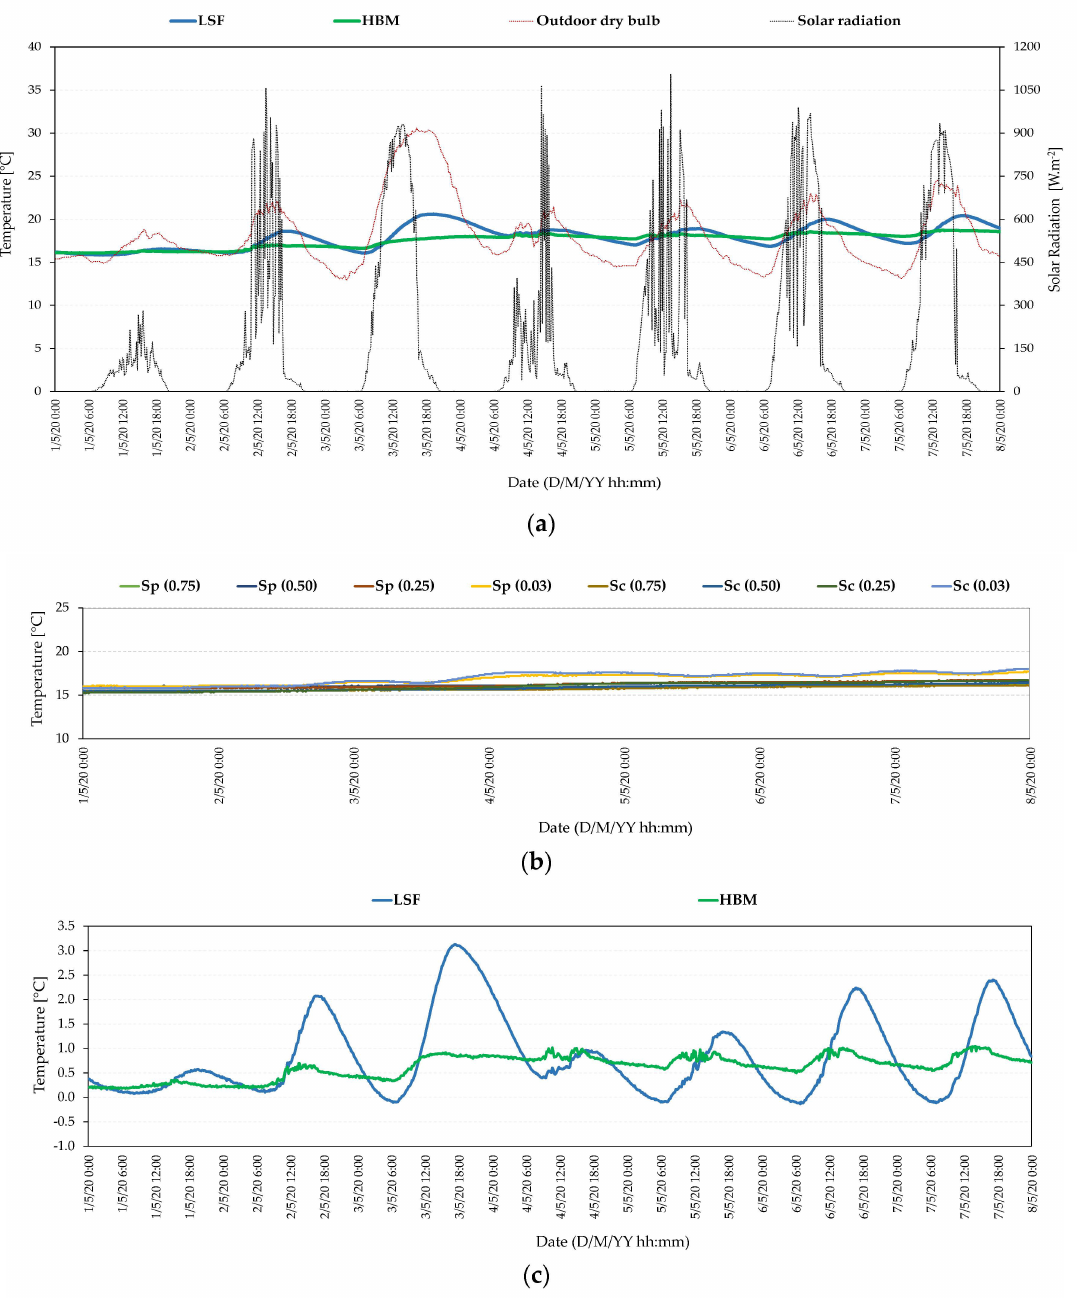
Figure 6. Shoulder season week analysis: ( a ) indoor air temperatures in the experimental test cells and outdoor environ- mental conditions; ( b ) soil temperatures at different depths and locations; ( c ) indoor air temperature vertical stratification between the inferior and superior monitoring